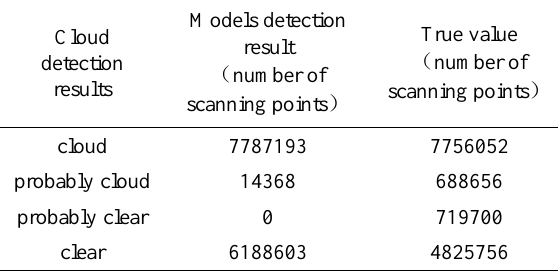
Table 9. Model cloud test results and true values on validation Figure 8. Cloud detection image at UTC 20180917061500. dataset Figure a is the CLM product of FY-4A, and Figure b is the detection result of the decision tree cloud detection model.